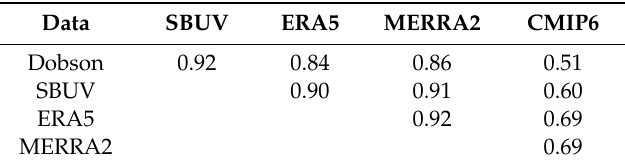
Pearson’s linear correlation coe ffi cient between annual mean total ozone over Faraday / Vernadsky measured with the Dobson spectrophotometer and retrieved from the